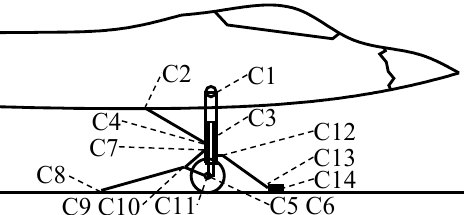
Figure 1. Carrier-based aircraft in the containment and tensioning phase.